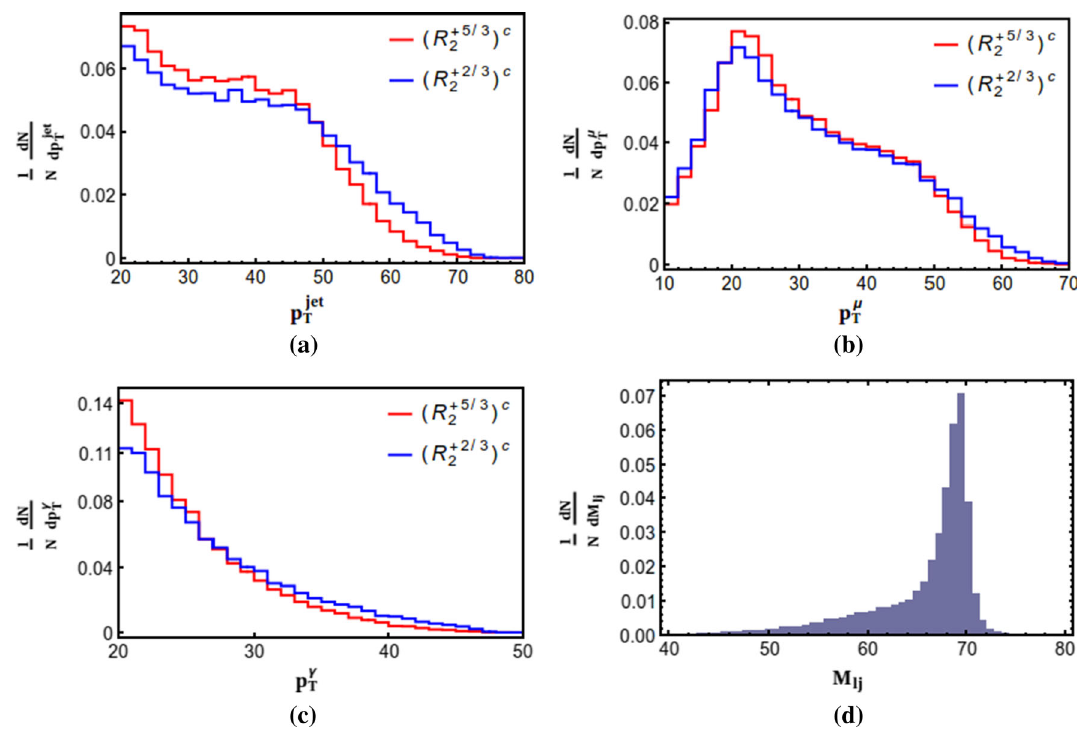
√ s = 318 . 12 GeV for the leptoquark R c